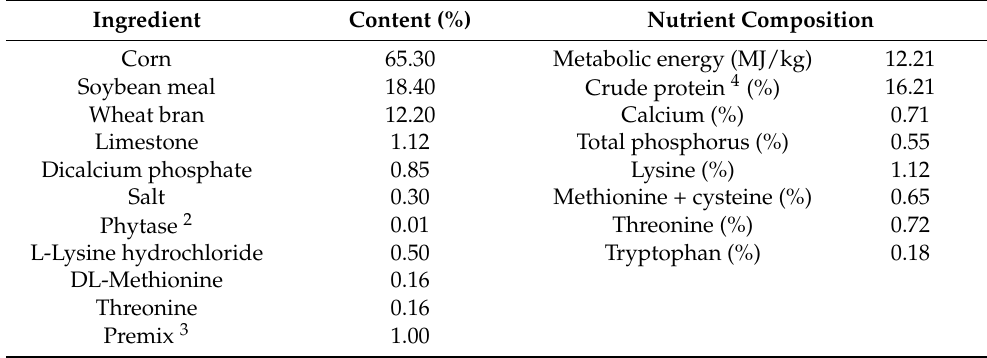
Table 1. Ingredients and composition of the basal diet 1 . Ingredient Content (%) Nutrient Composition Corn 65.30 Soybean